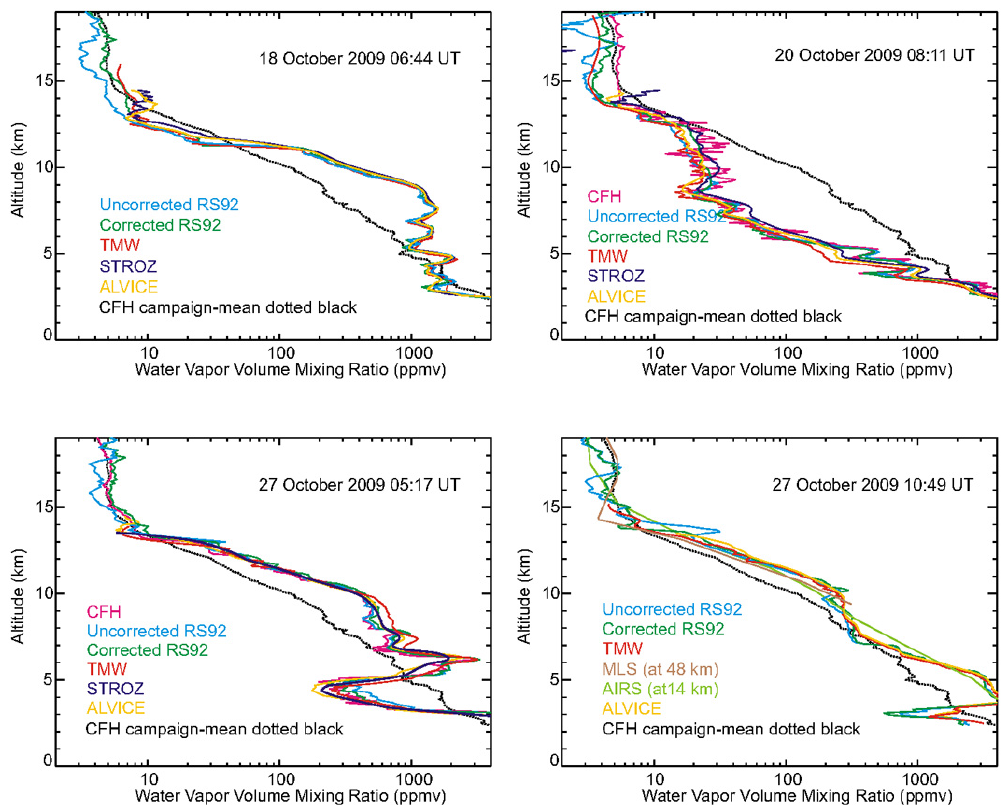
Fig. 12. Example of four water vapor mixing ratio profiles measured simultaneously by TMW, two other lidars, CFH, Aura-MLS, and RS92 radiosondes during